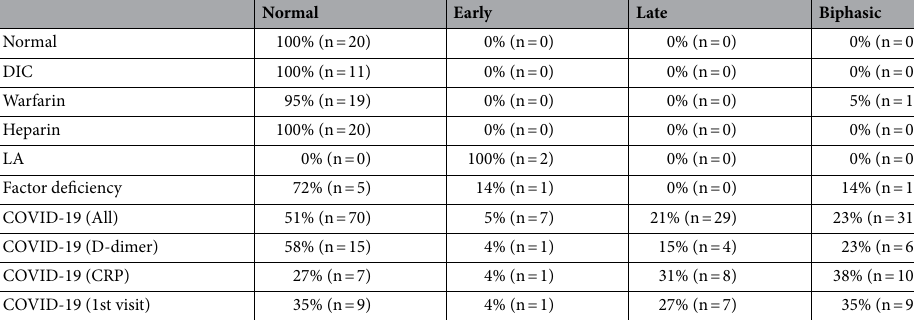
Table 1. Frequency of abnormal patterns of APTT second-derivative curves. χ 2 < 0.01 for all the analytical models when all the APTT tests were analyzed together, when only the APTT tests performed at a time point corresponding to the maximum D-dimer or CRP level were analyzed, or when only the APPT tests performed at the time of each subject’s initial visit to the hospital first were